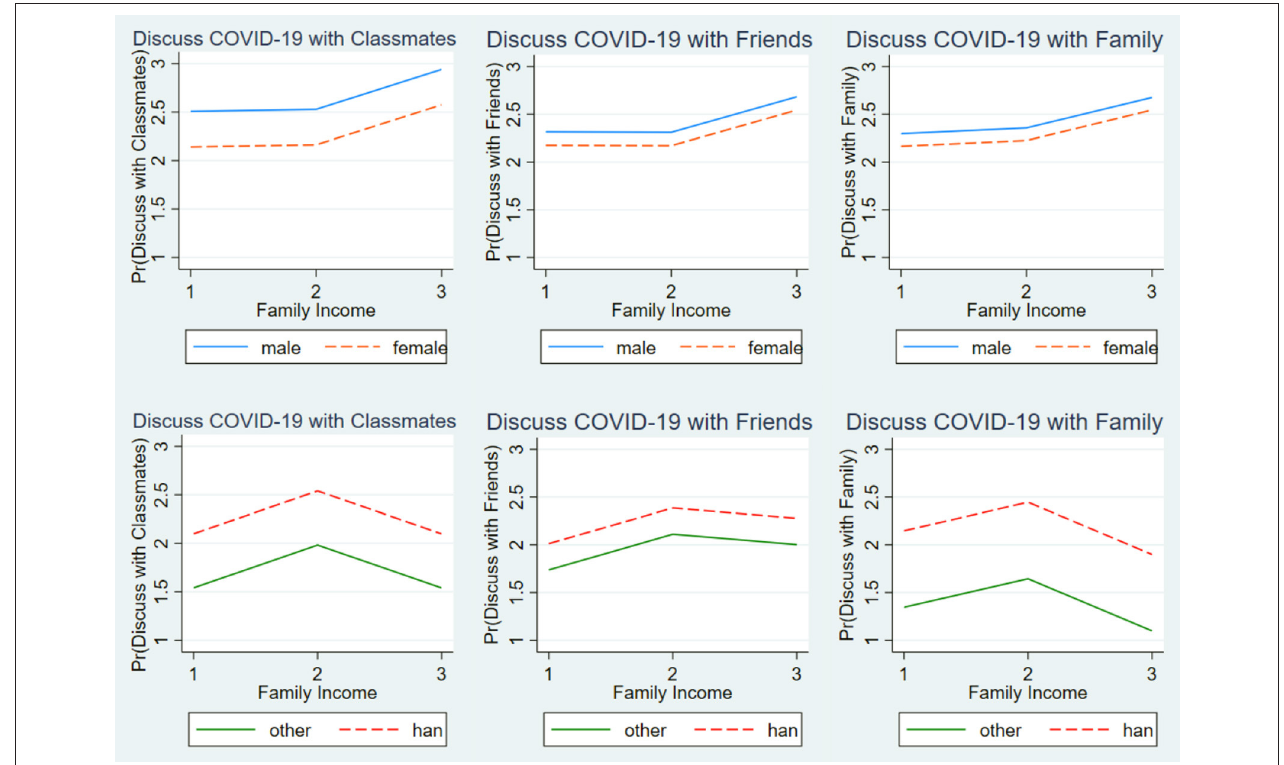
FIGURE 1 | The relationship between family income and students’ COVID-19 awareness by sex and